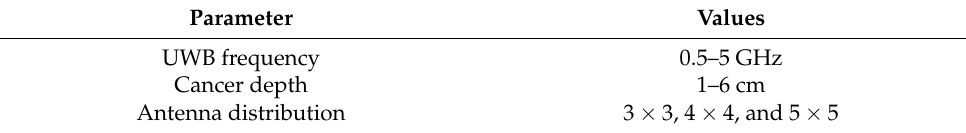
Table 1. Parameters